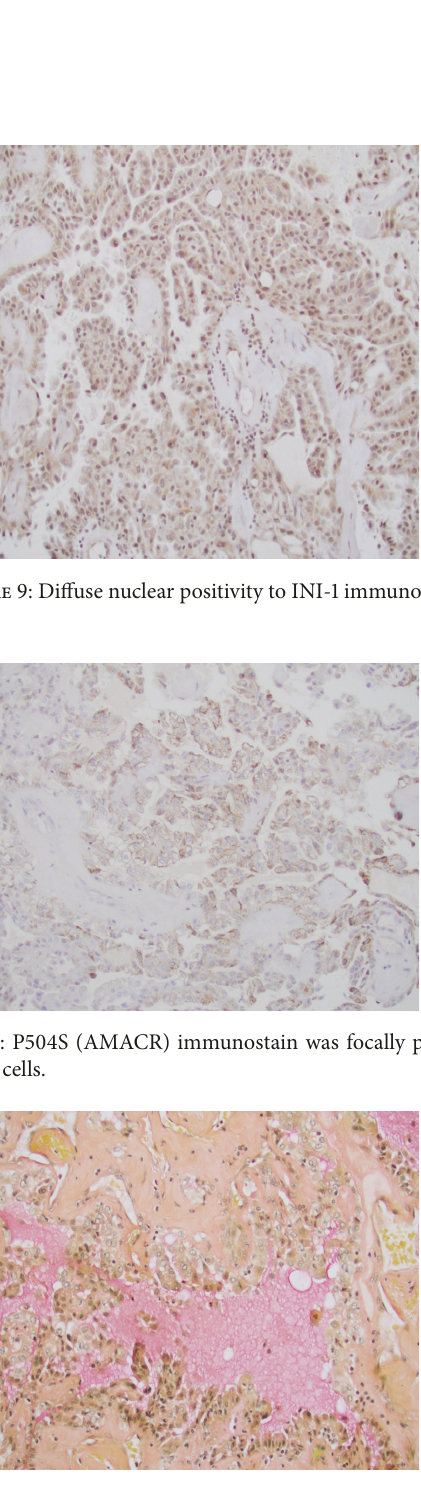
Figure 11: Mucicarmine stain highlighting the background